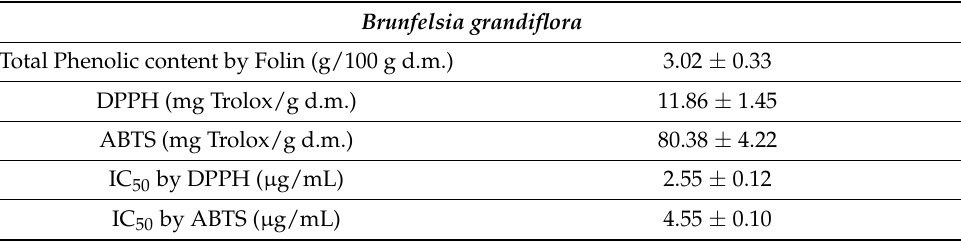
Table 1. Total polyphenolic content and antioxidant capacity of lyophilized extract obtained from Brunfelsia grandiflora .